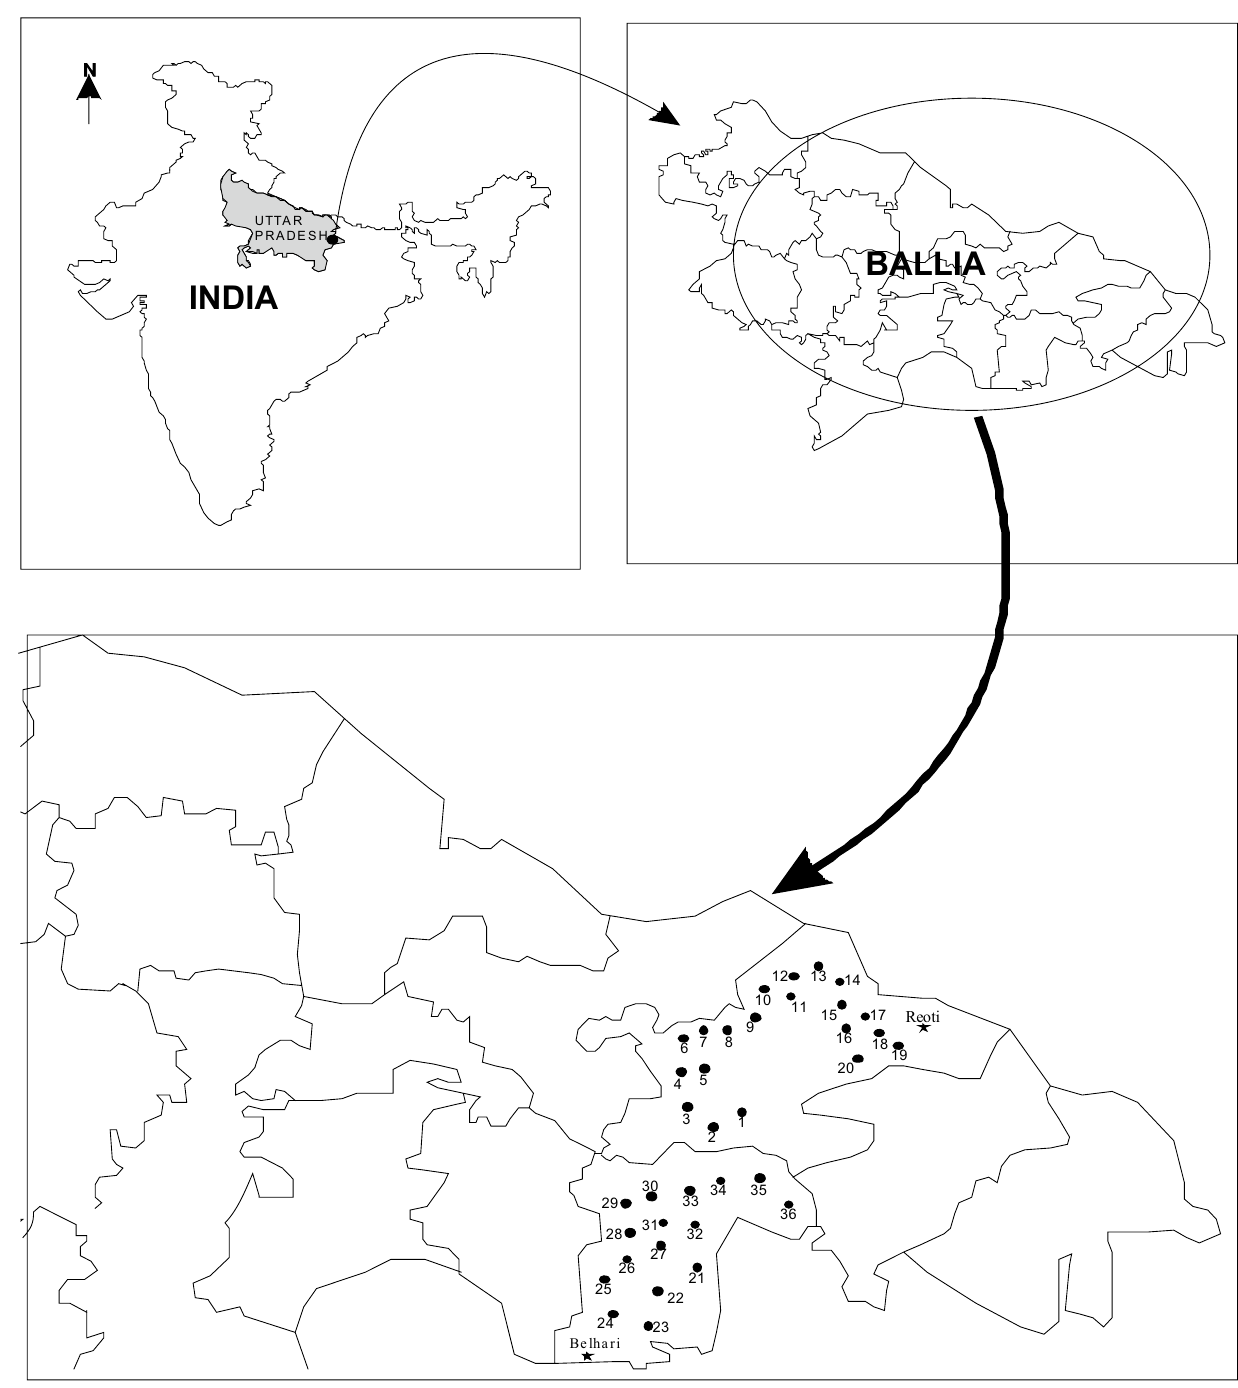
Fig. 7 Map showing sampling locations for